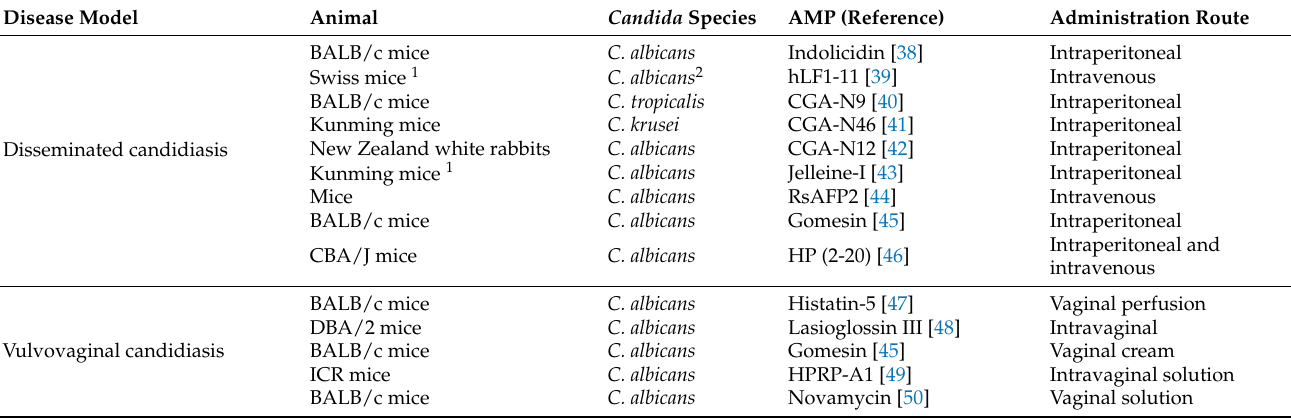
Table 2. Antimicrobial peptides (AMPs) that have been assessed in diverse animal models of Candida